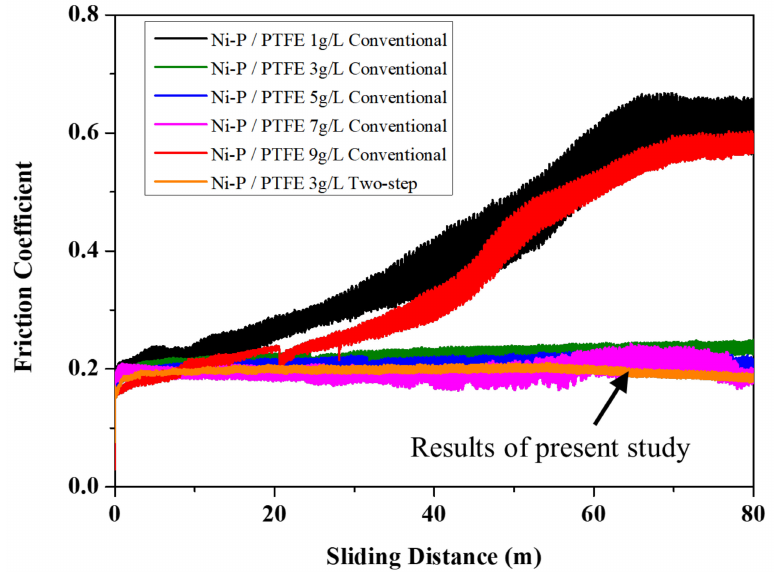
Figure 5. Friction coefficient of Ni-P-PTFE plating layer under various PTFE concentrations and